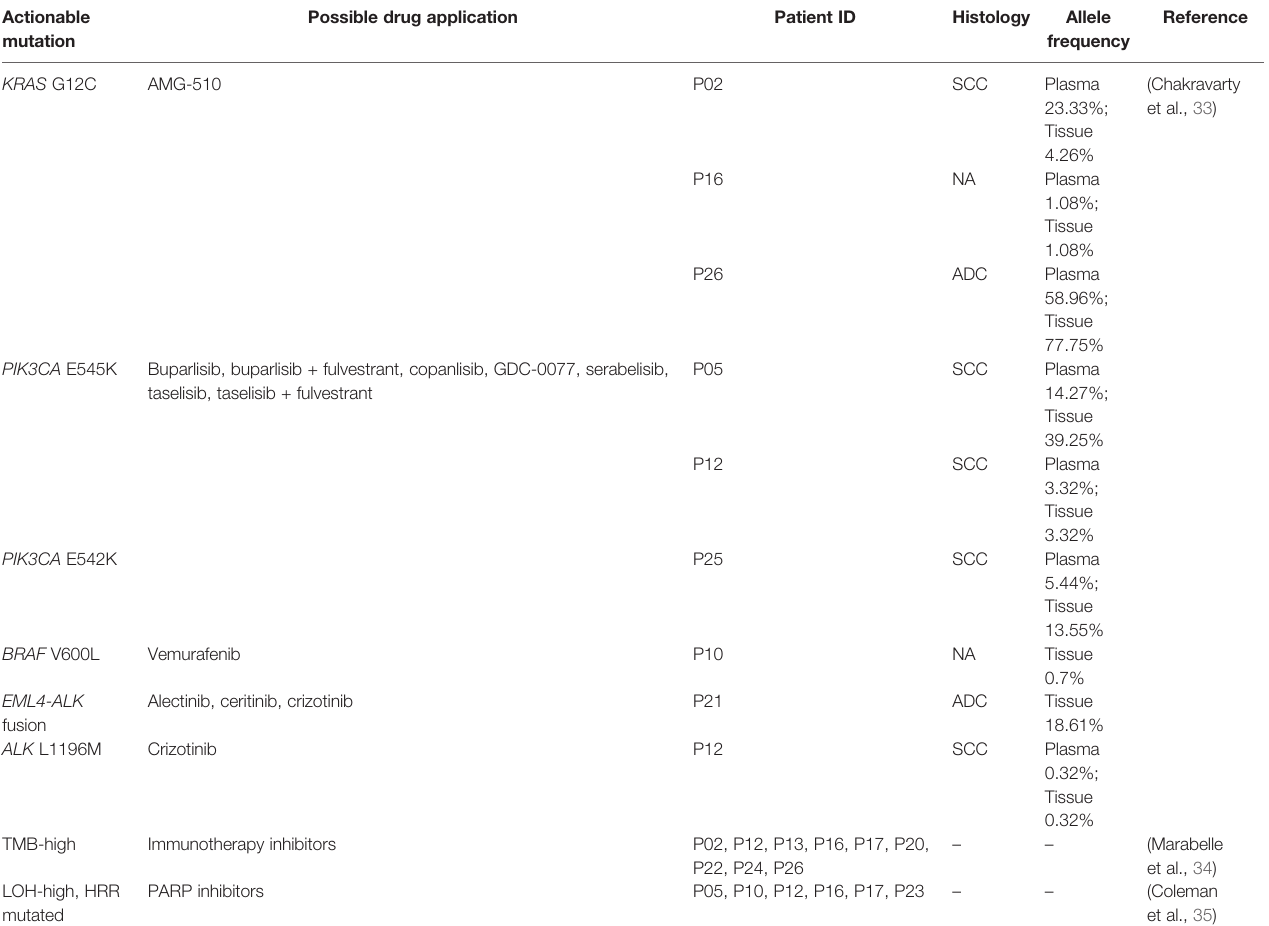
TABLE 2 | Actionable mutations detected in patients with unknown primary